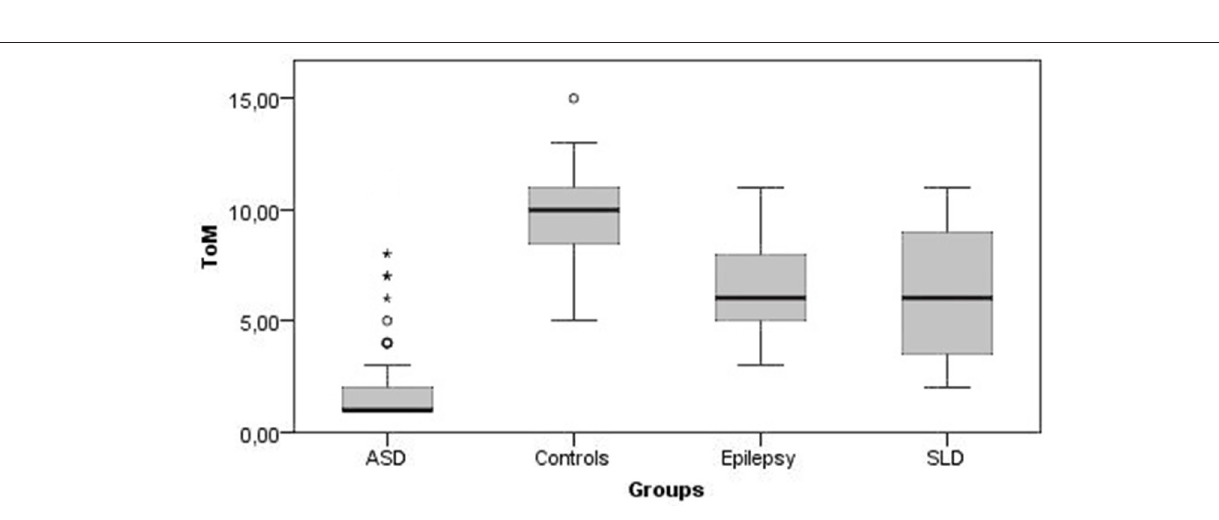
FIGURE 2 | Theory of Mind mean scores. ToM, theory of mind; ASD, autism spectrum disorder; SLD, specific learning